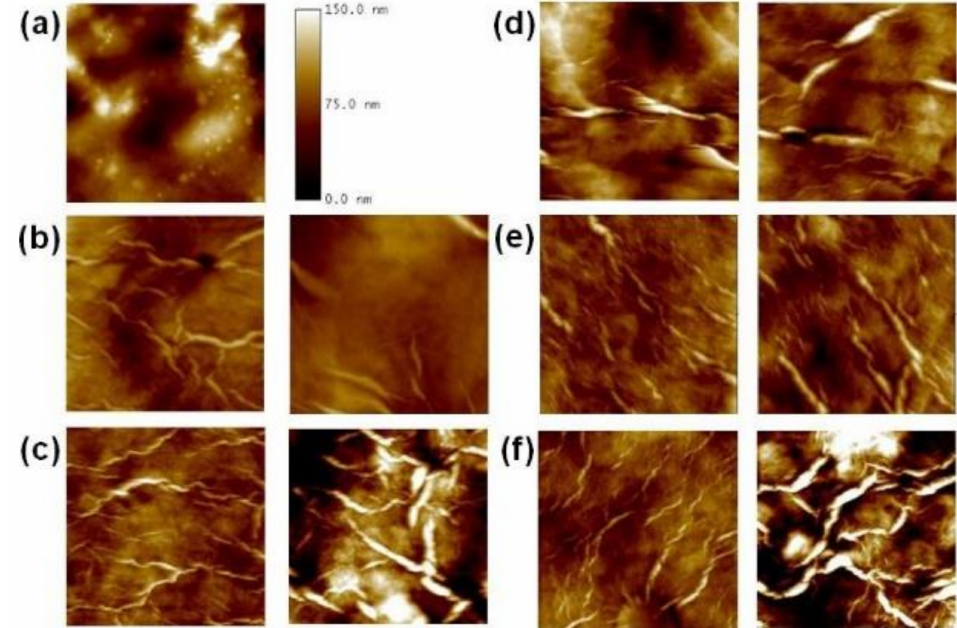
Figure 6. TM-AFM topography images of different hydrogel formulations on a mica support visu- alized in air. ( a ) Porcine stomach mucin. From ( b ) to ( f ) different hydrogels alone (on the left side) and in the presence of mucin (on the right side). ( b ) F10; ( c ) F11; ( d ) F12; ( e ) F13; ( f ) F14. For all the images: scan area 5 × 5 µ m 2 , vertical scale 150